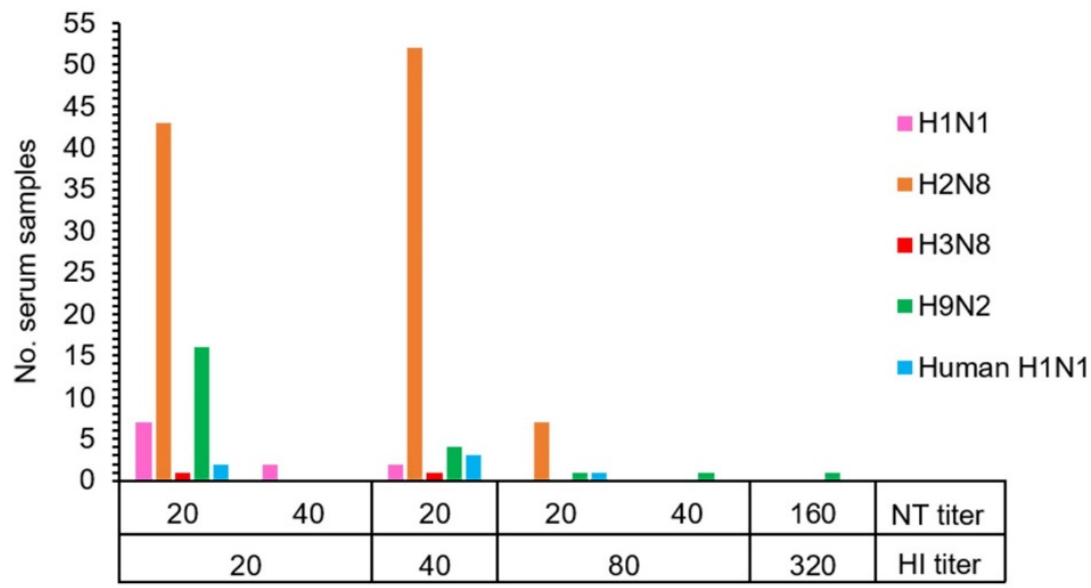
Figure 1. The correlation between hemagglutination inhibition (HI) and neutralization (NT) antibody titers of 128 individual macaques with seropositivity against subtypes of influenza A virus. Among the 128 positive serum samples, 15 (11.7%) individual samples were found antibodies against more than one subtype of influenza A virus which AIV H1, H2, H3, H9, and human H1 (NP-045) were identified. Of those, 14 samples showed seropositivity against two subtypes representing 93.3% (14/15). Combinations of two subtypes found in the positive samples comprised AIV H1 + AIV H2 (40.0%, 6/15), AIV H1 + AIV